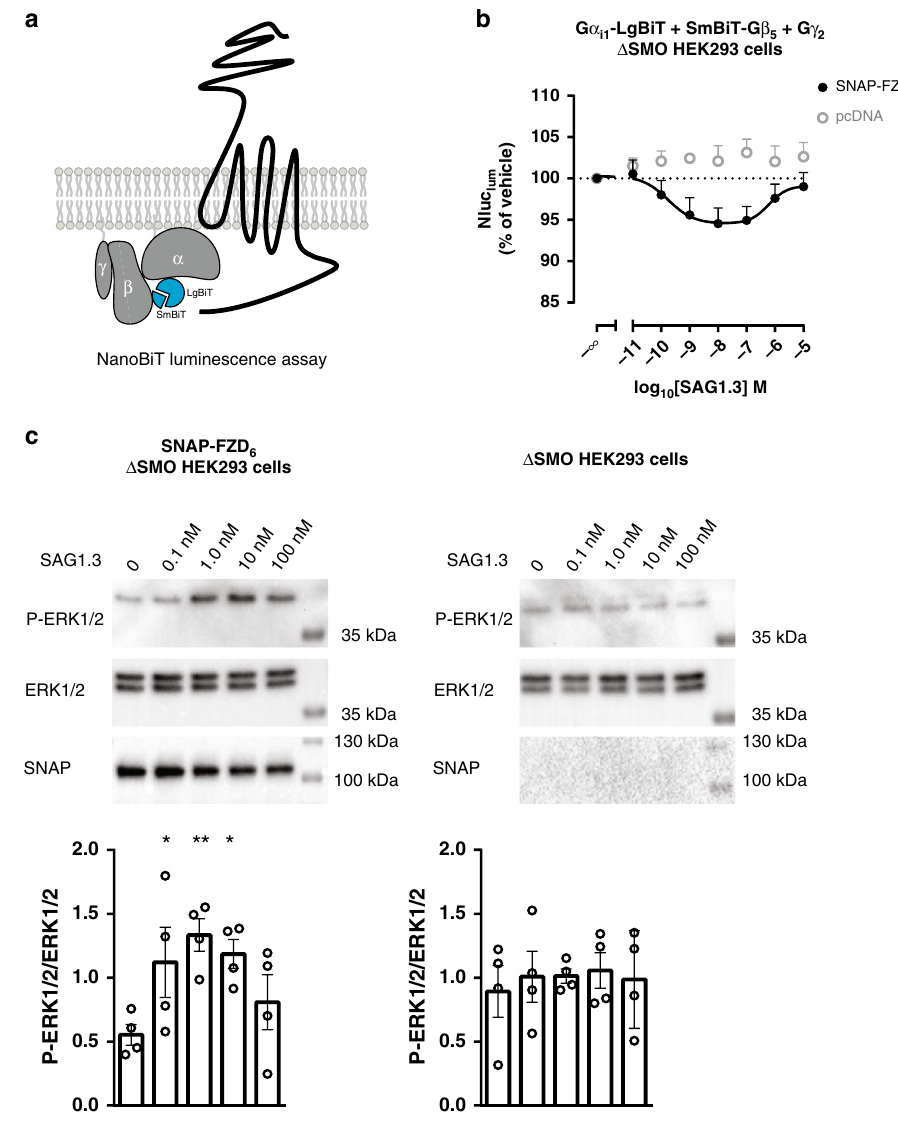
Fig. 5 SAG1.3 induces FZD 6 -dependent dissociation of heterotrimeric G i and phosphorylation of ERK1/2. a Schematic view of the split NanoBiT luciferase assay. Ligand stimulation of a GPCR results in dissociation of the heterotrimeric G protein and a decrease in the Nluc luminescence. b SAG1.3 stimulation of SNAP – FZD 6 transiently overexpressed in Δ SMO HEK293 cells resulted in a concentration-dependent, biphasic decrease in basal luminescence as a measure of the dissociation of the G α i1 – LgBiT, SmBiT – G β 5 , and G γ 2 complex ( fi lled black circles). pcDNA served as no-receptor-control (open gray circles). Data are represented as mean ± s.e.m. of n = 6 individual experiments. c SAG1.3 (10 min) induced phosphorylation of ERK1/2 (P-ERK1/ 2) in a biphasic manner only in SNAP – FZD 6 -transfected Δ SMO HEK293 cells. Serum starved cells were pretreated with C59 (5 nM; overnight). Representative immunoblots are shown. Data are presented as mean ± s.e.m. of n = 4 individual experiments; F (4,14) = 3.141. * P < 0.05, ** P < 0.01 (one-way ANOVA). Source data are provided as a Source Data fi